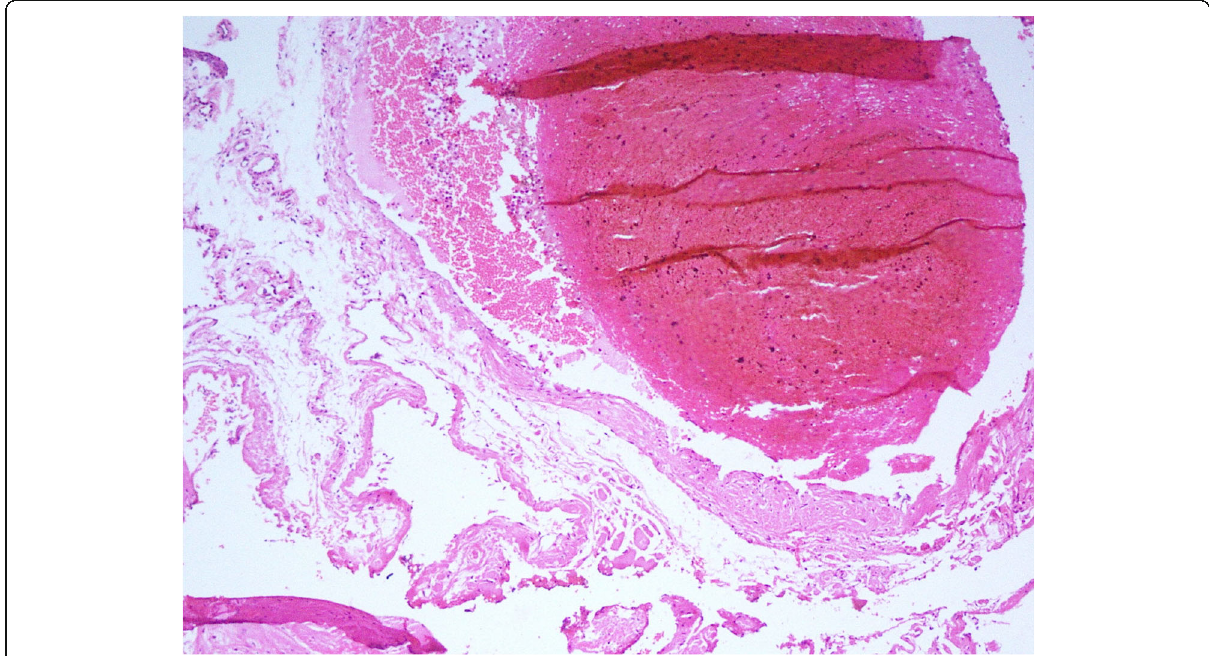
Fig. 4 Digital images of the slides confirming the diagnosis of cavernous venous